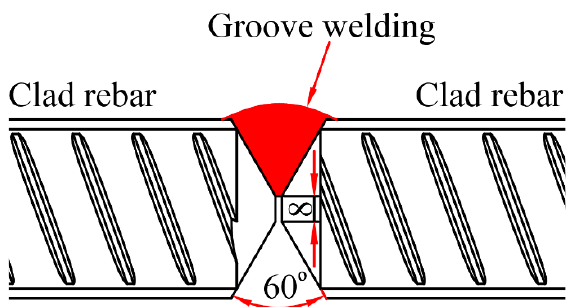
Figure 13. Schematic of the rebar groove welding.